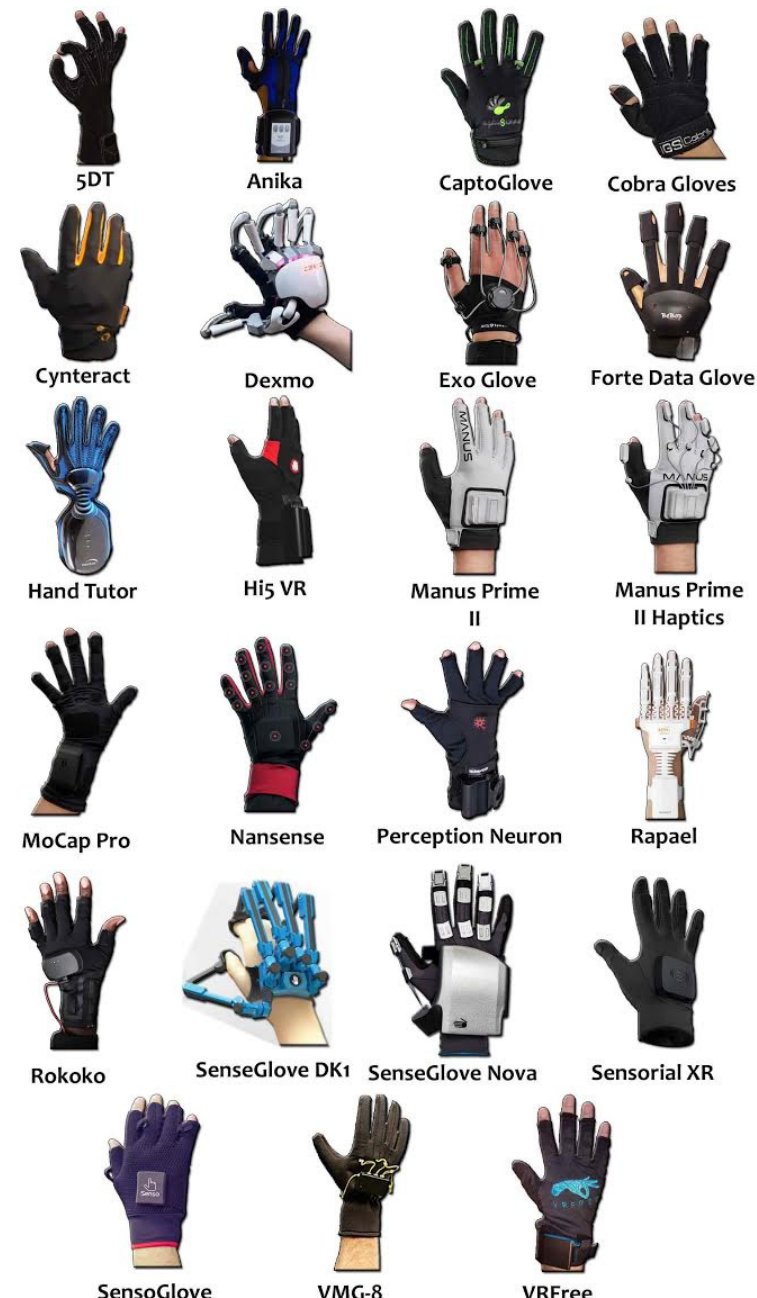
Figure 7. Pictures of commercial smart gloves (the VMG 35 Haptic is not included because it is like the VMG-8).